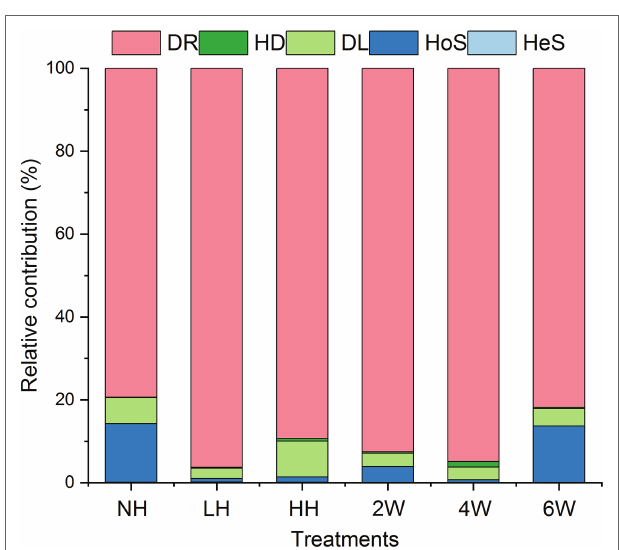
FIGURE 3 | Relative importance of different ecological processes in response to foliar